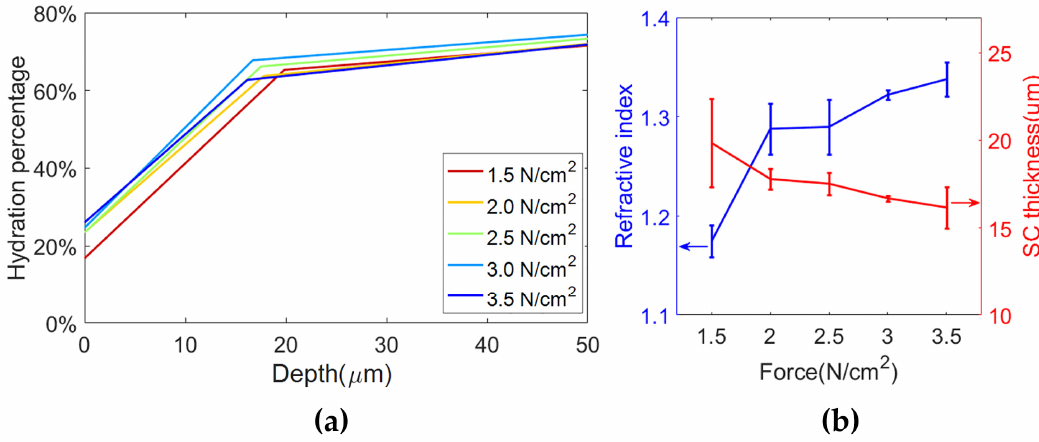
Figure 8. ( a ) Water profile in skin under different applied pressures; ( b ) Refractive index of dehydrated skin and SC thickness under different pressures. The error bars in ( b ) are the standard deviation of three measurements [38].